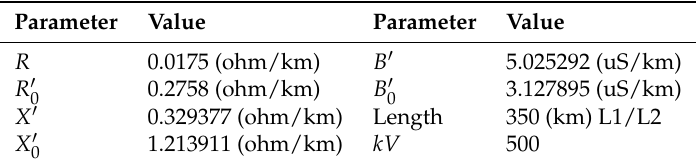
Table A5. Parameters of the transmission